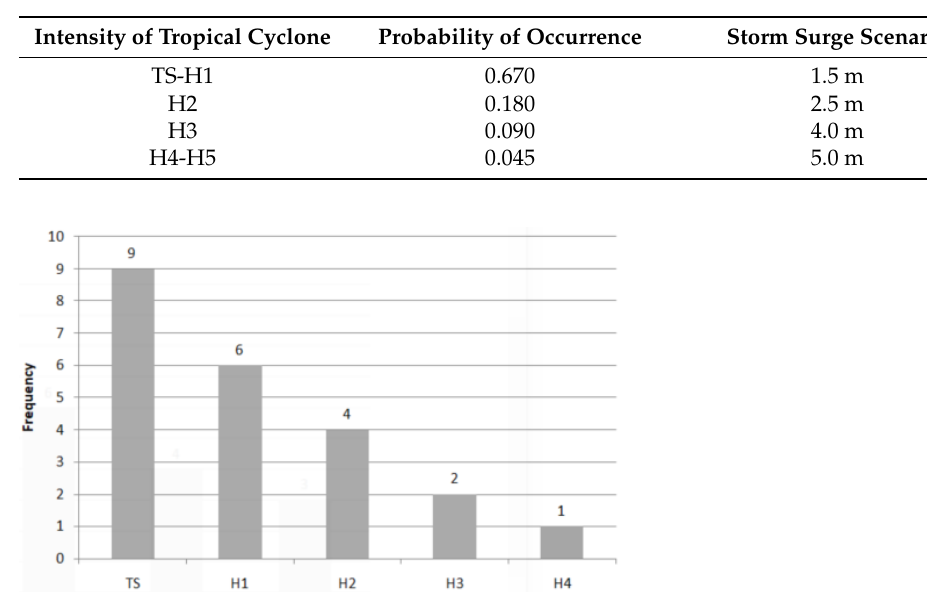
Table 3. Scenarios of storm surge and their relationship with the intensity of tropical cyclones and their probability of occurrence.